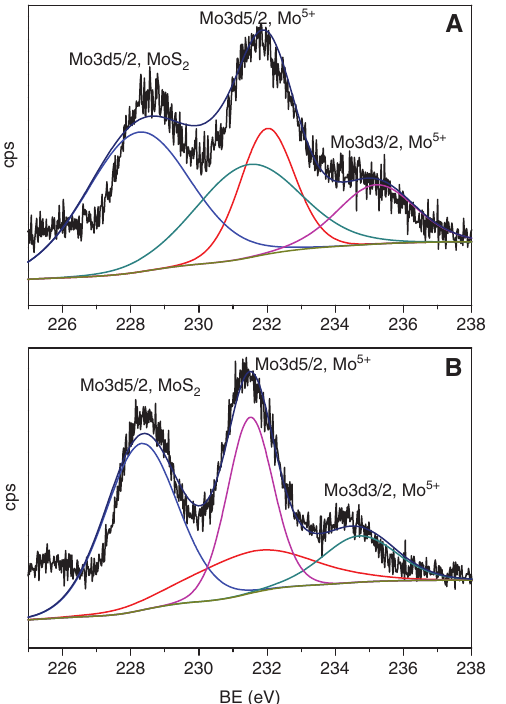
and 2 Figure 8: XPS spectra of S2p level for nanospheres (A) NiMoS (B) CoMoS . 2